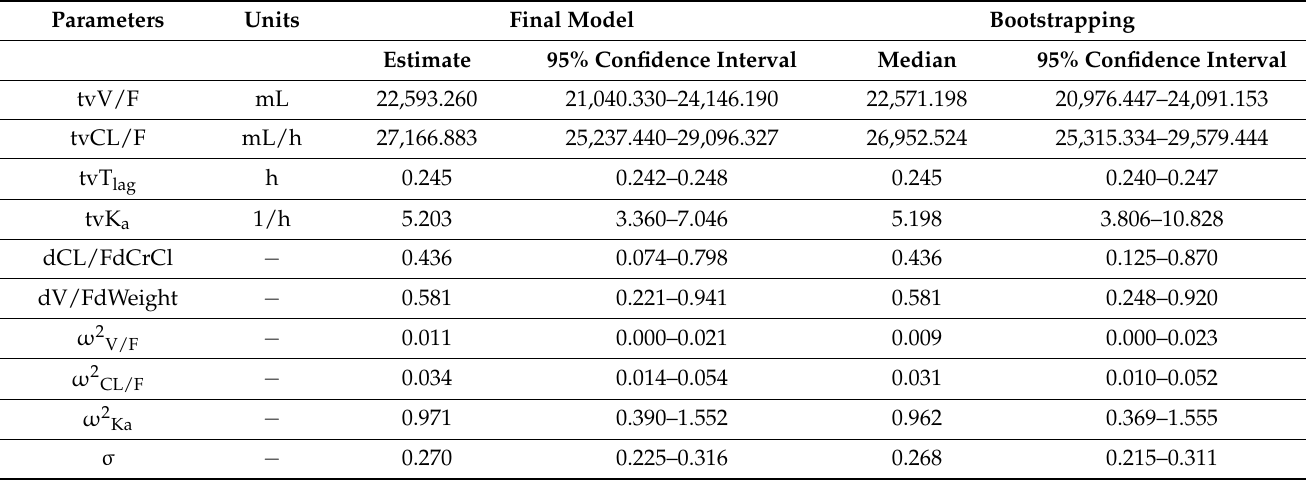
Table 6. Estimated population pharmacokinetic parameter values of cefaclor and bootstrap validation ( n = 1000).